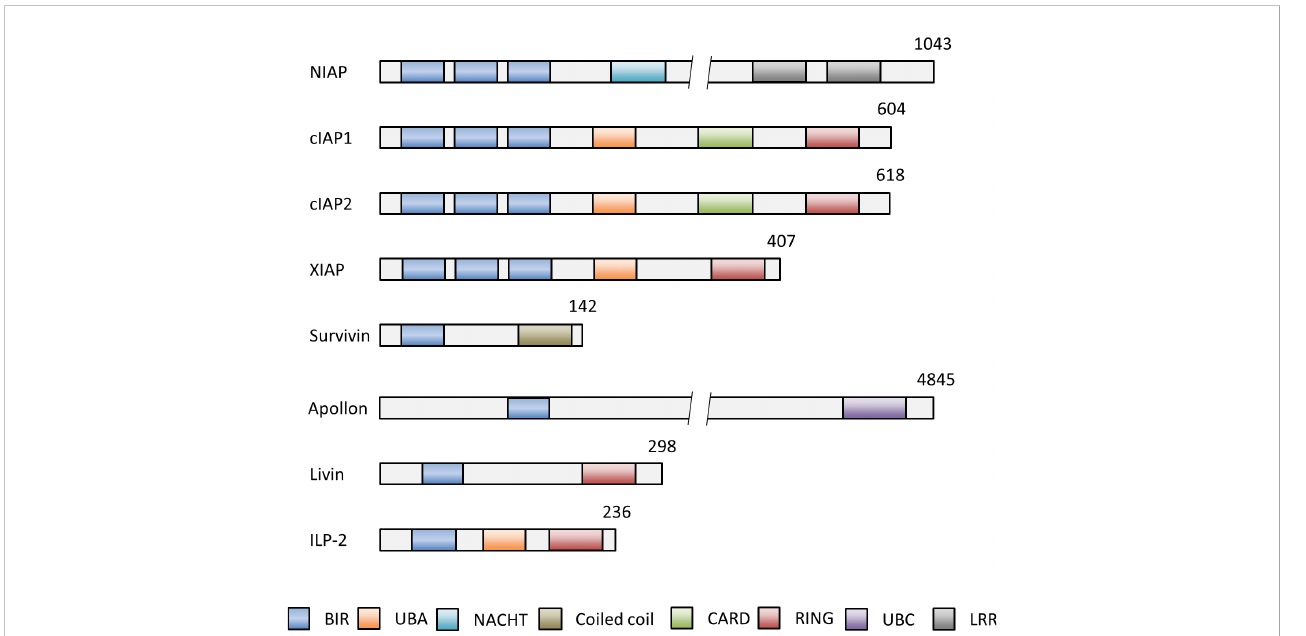
FIGURE 2 Schematic representation of the domain structures of the IAP members NIAP (BIRC1), cIAP1 (BIRC2), cIAP2 (BIRC3), XIAP (BIRC4), Survivin (BIRC5), Apollon (BIRC6), Livin (BIRC7) and ILP-2 (BIRC8). Numbers indicate numbers of amino acids of each IAP. The baculovirus IAP repeat (BIR) domain can bind and inhibit caspases. The, really interesting new gene (RING) domain has E3 ligase activity and for (auto-) ubiquitination of proteins for subsequent proteasomal degradation. The caspase activation and recruitment domain (CARD) domain mediates the autoinhibition of the E3 ubiquitin ligase activity by preventing RING dimerization. Other functional domains of IAPs comprise the ubiquitin associated domain (UBA) for binding to polyubiquitin chains for cell survival, activation of NF-kB signaling and proteasomal degradation, the ubiquitin conjugation domain (UBC) with E2 ubiquitin conjugating ligase activity and the neuronal apoptosis inhibitory protein domain (NACHT) with nucleoside-triphosphatase (NTPase) activity. BIR, aculorvirus IAP repeat; CARD, caspase recruitment domain; LRR, leucine-rich repeat; NACHT, neuronal apoptosis inhibitory protein; UBA,